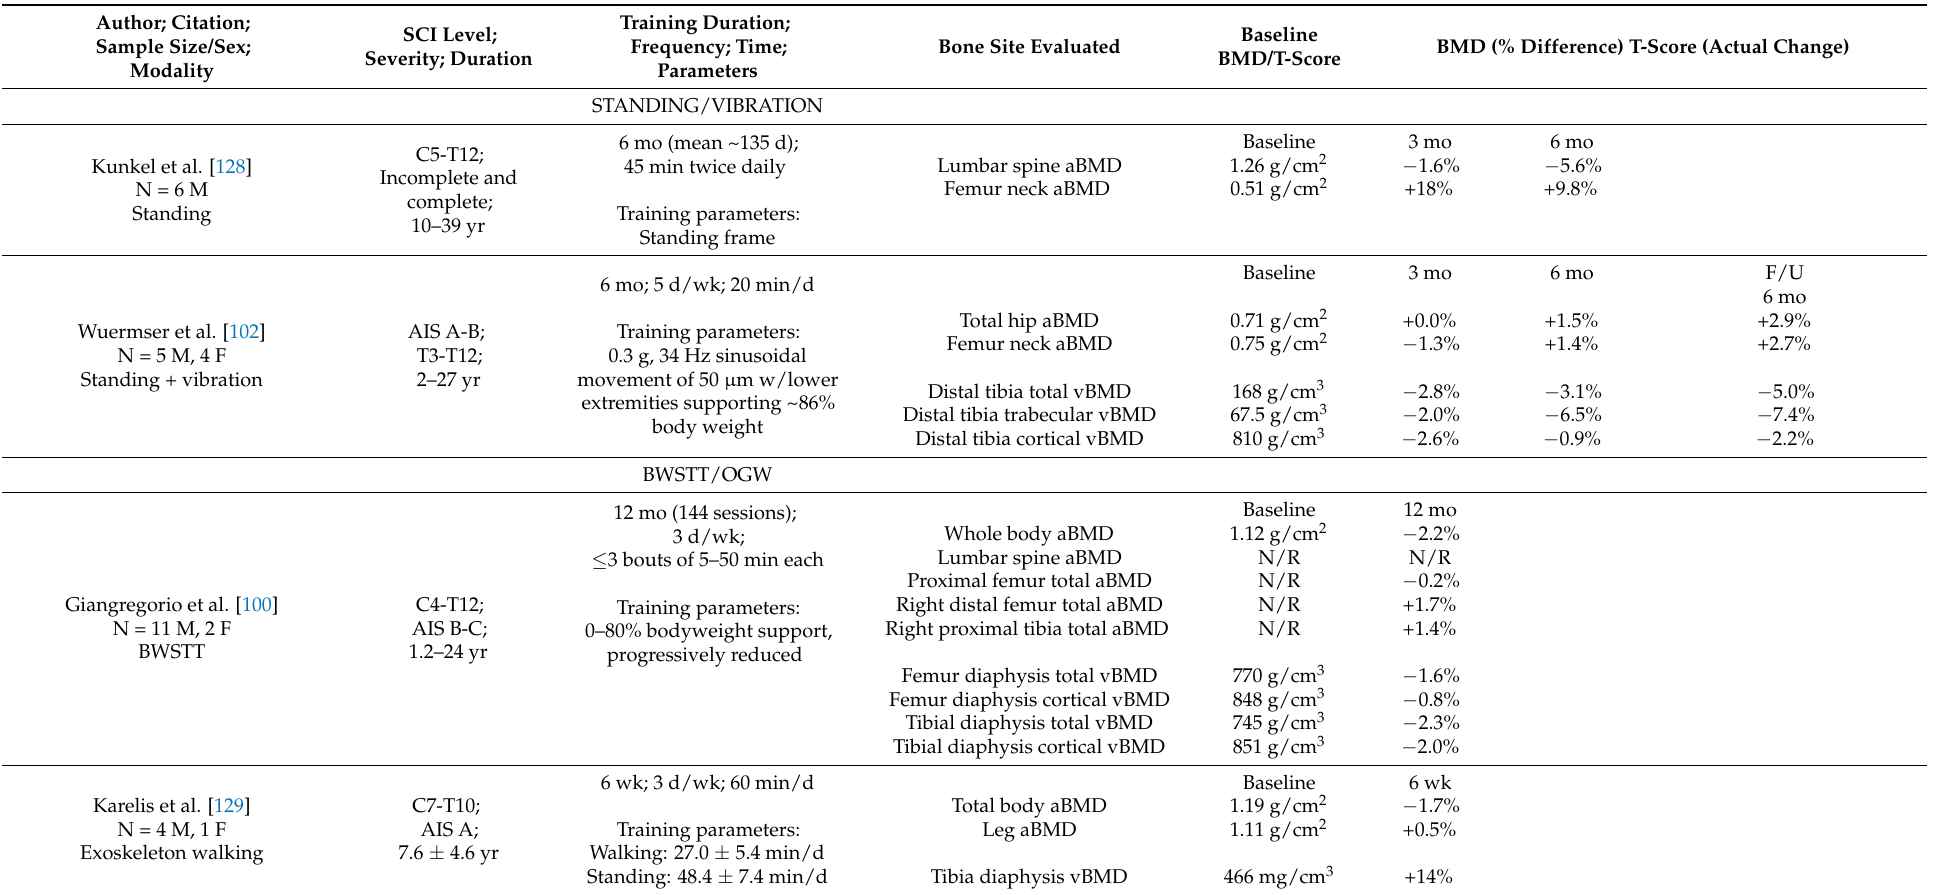
Table 4. Uncontrolled interventional studies evaluating the effects of activity-based physical therapy (ABPT) and/or loading on bone mineral density (BMD) or T-scores in adults with chronic spinal cord injury